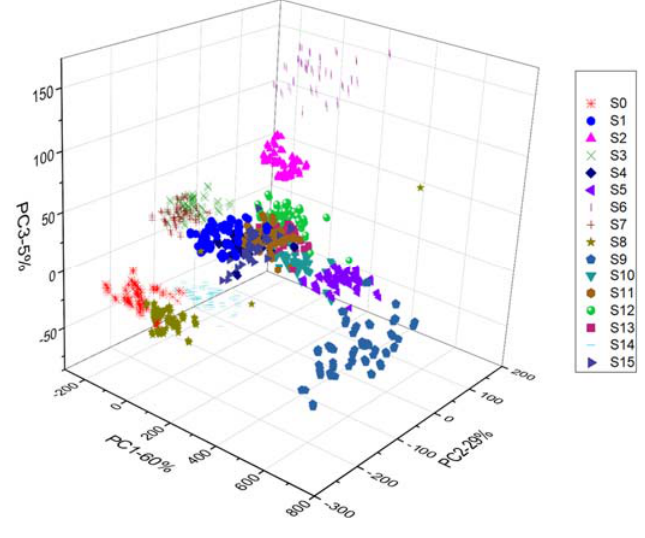
Figure 3. 3-dimensional distribution of individual samples.